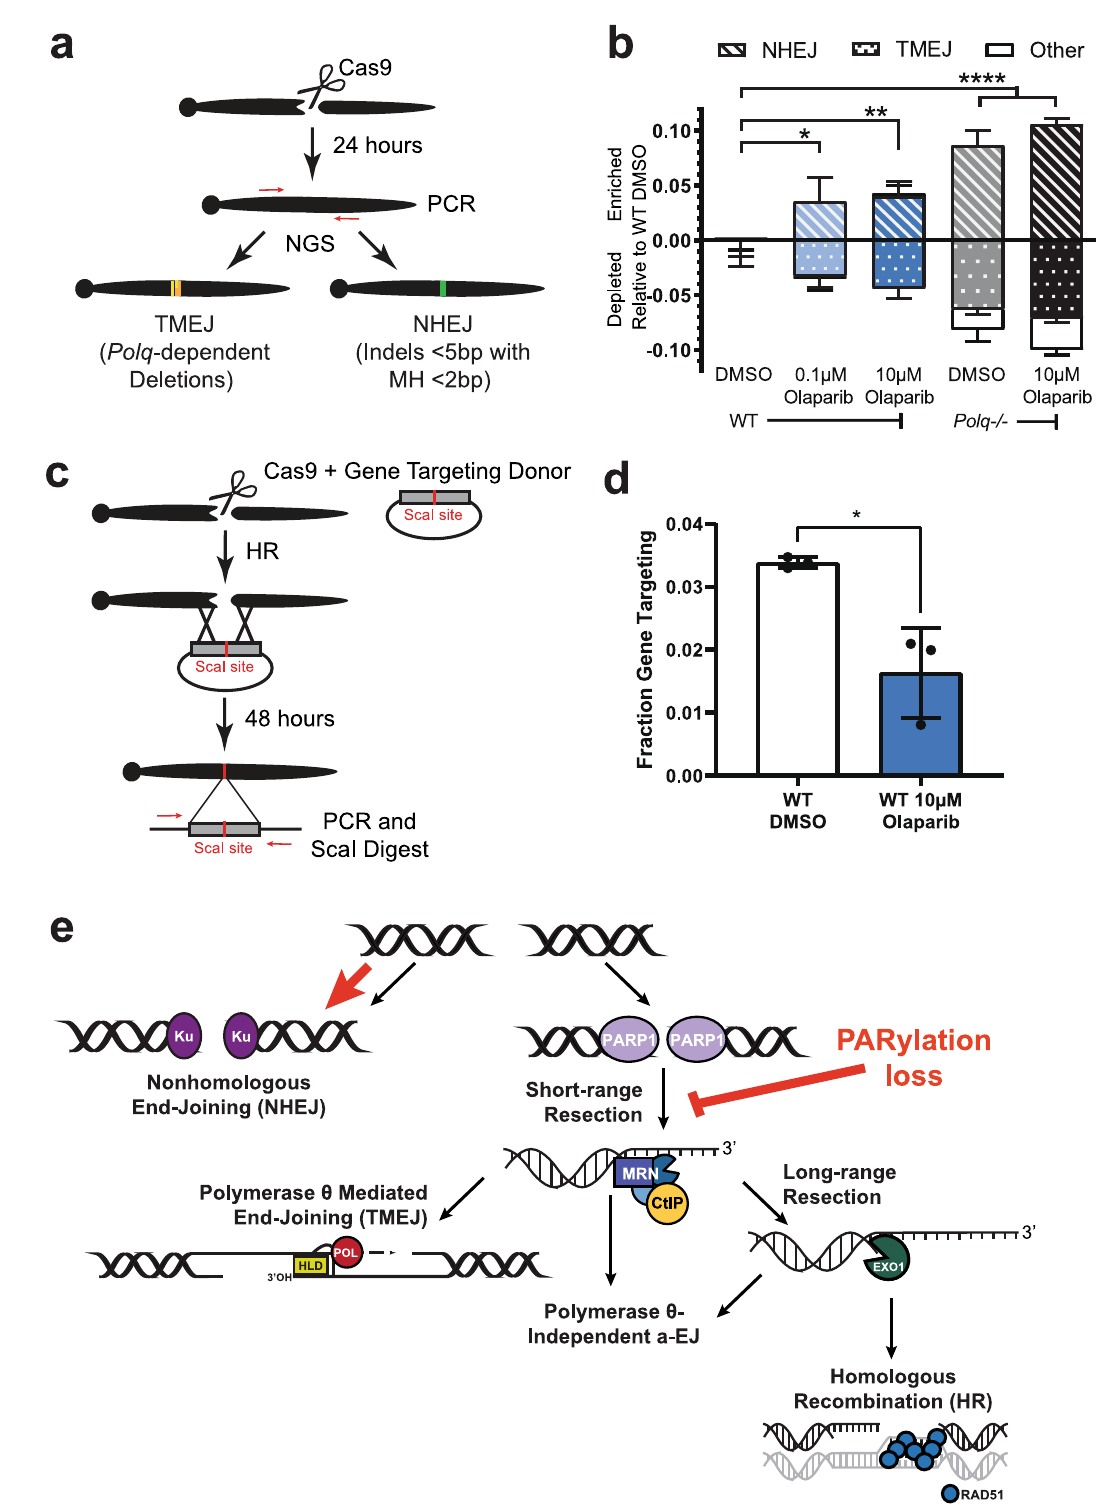
Fig. 6 | NHEJ compensates for the loss ofTMEJ in the absence ofPARPactivity. a Amplicon-based, next-generation sequencing (NGS) work fl ow used to char- acterize all TMEJ and NHEJ repair products. b Percent of NHEJ (striped bars), TMEJ (dotted bars),and allothersequences(whitebars)enrichedordepletedrelativeto DMSO-treated WT MEFs. Data shown are mean±SD ( n =3). Statistical signi fi cance of differences, relative to WT DMSO, refers to NHEJ and TMEJ and was determined by two-wayANOVA (* p <0.0017, ** p <0.0008, **** p <0.0001). Polq-/- MEFs treated with 10 µ M olaparib werethe only conditionsigni fi cantly different from WT DMSO